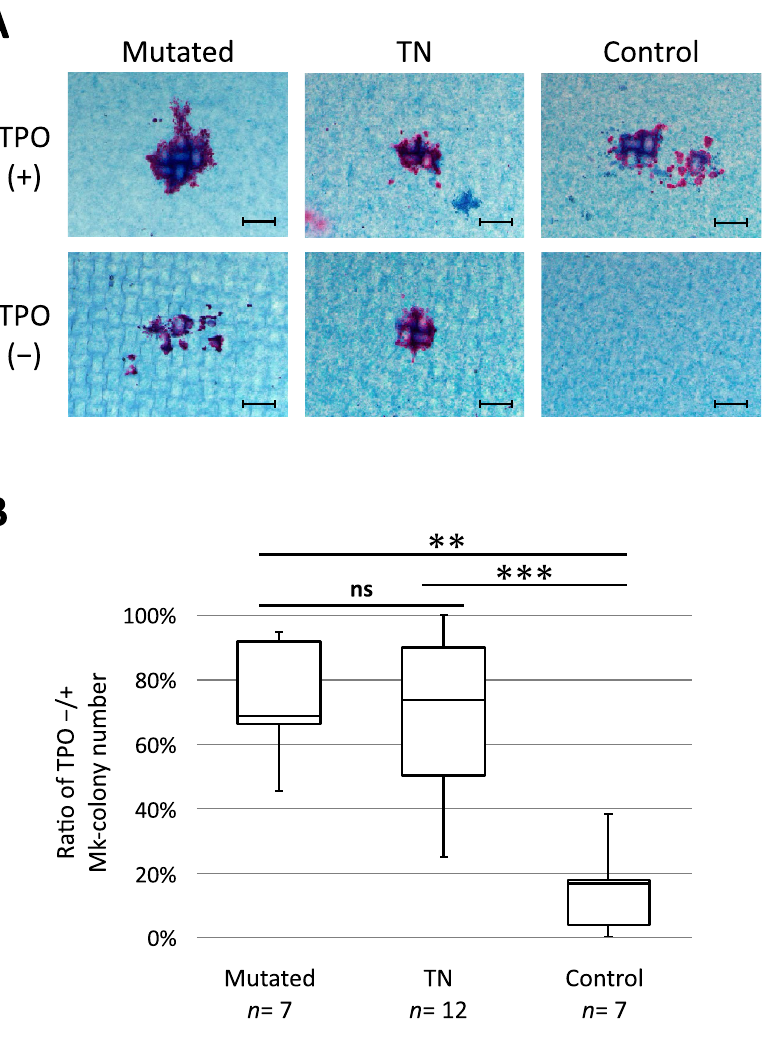
Figure 5. Cell-autonomous megakaryopoiesis in hematopoietic stem/progenitor cells in TN-ET. ( A ) Representative images of megakaryocytic colonies (CD42b-positive) from CD34-positive BM cells from the indicated patients and controls. Scale bar indicates 100 µm. ( B ) Relative ratio of the number of megakaryocytic colonies for the indicated patients and controls formed in the presence and absence of TPO. ** < 0.01, *** < 0.001, ns: not